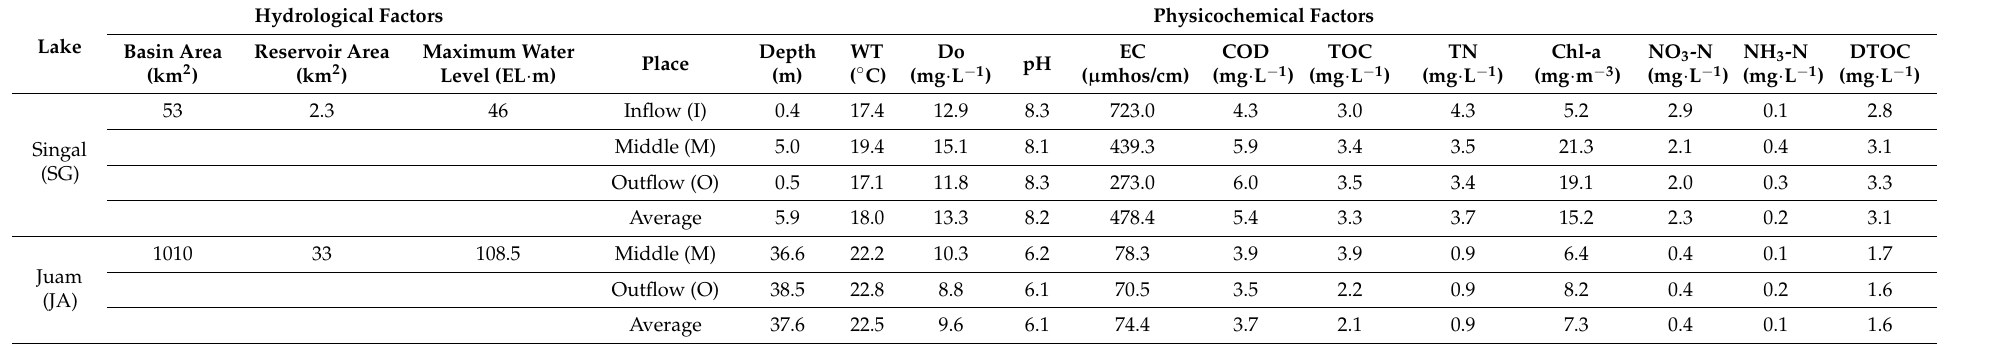
Table 2. Hydrological and physicochemical factors in each